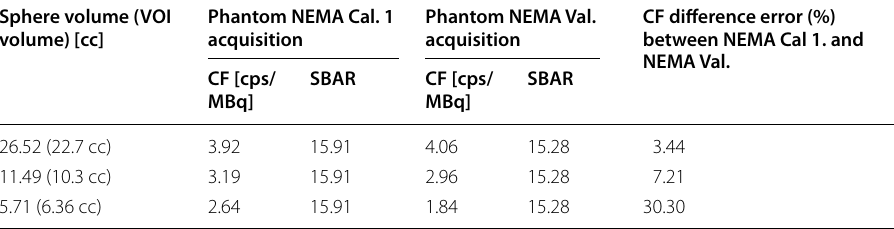
Table 2 Comparison between CFs calculated from acquisitions NEMA Cal.1 and NEMA Val. for comparable sphere–background activity ratios